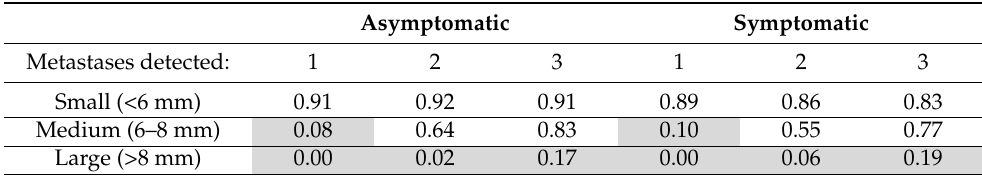
Proportions of oligo+ per risk sub-group. Grey fields represent the low-risk